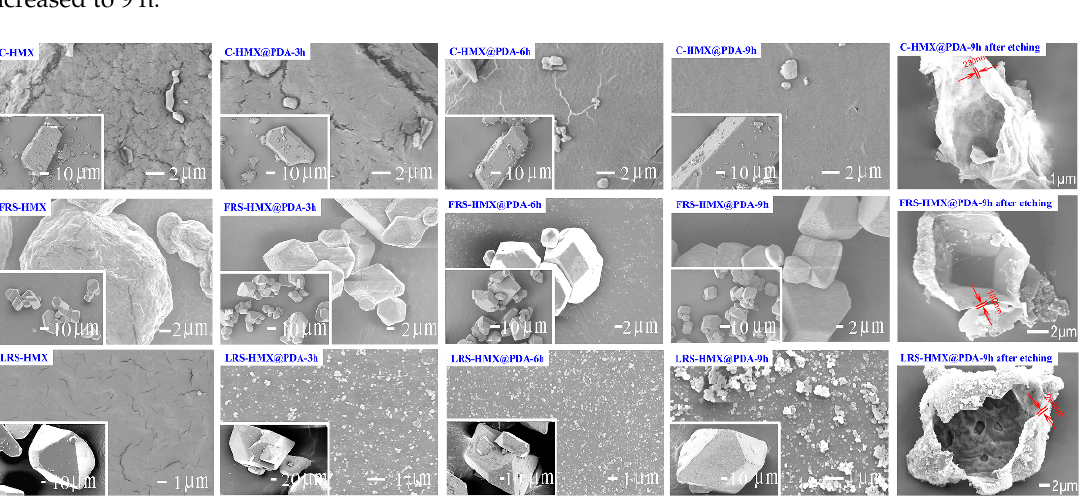
Figure 2. SEM micrographs of the structure morphologies for different HMX and PDA coated specimens.